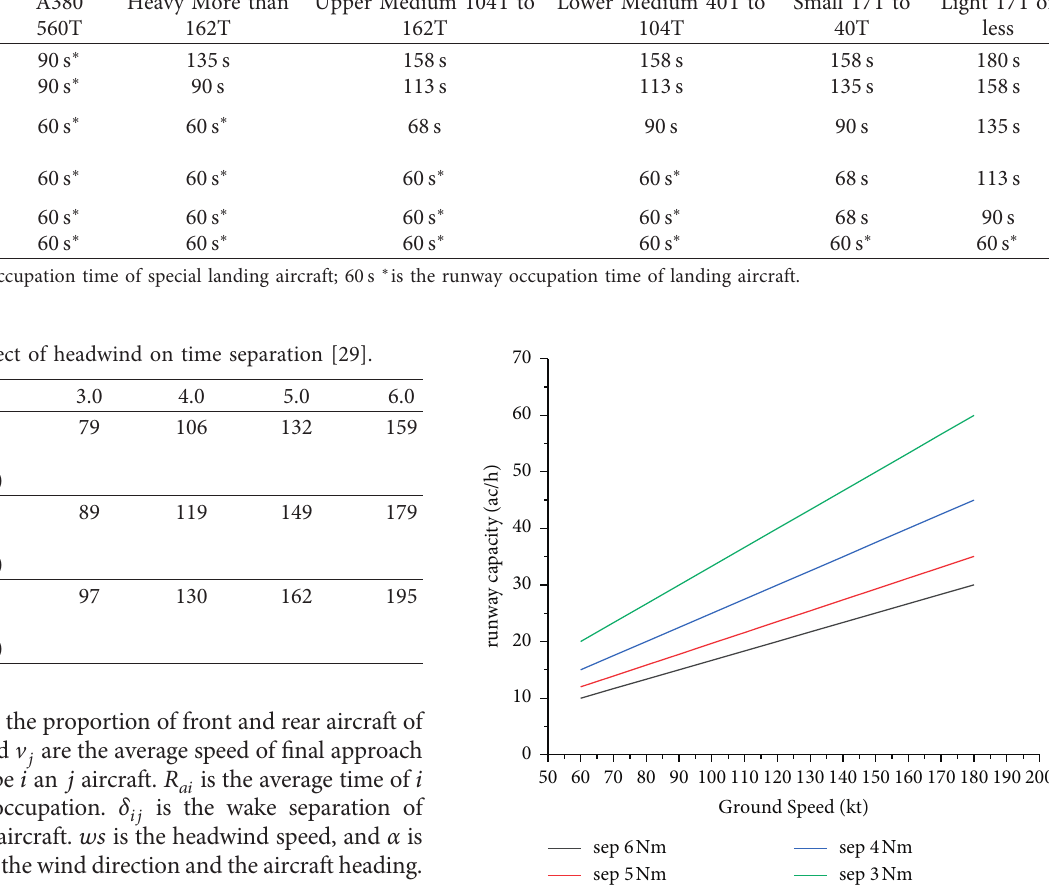
Figure 6: Variation of runway capacity with the ground speed at different distance separations. With the decrease in ground speed, the runway capacity decreases at the same distance